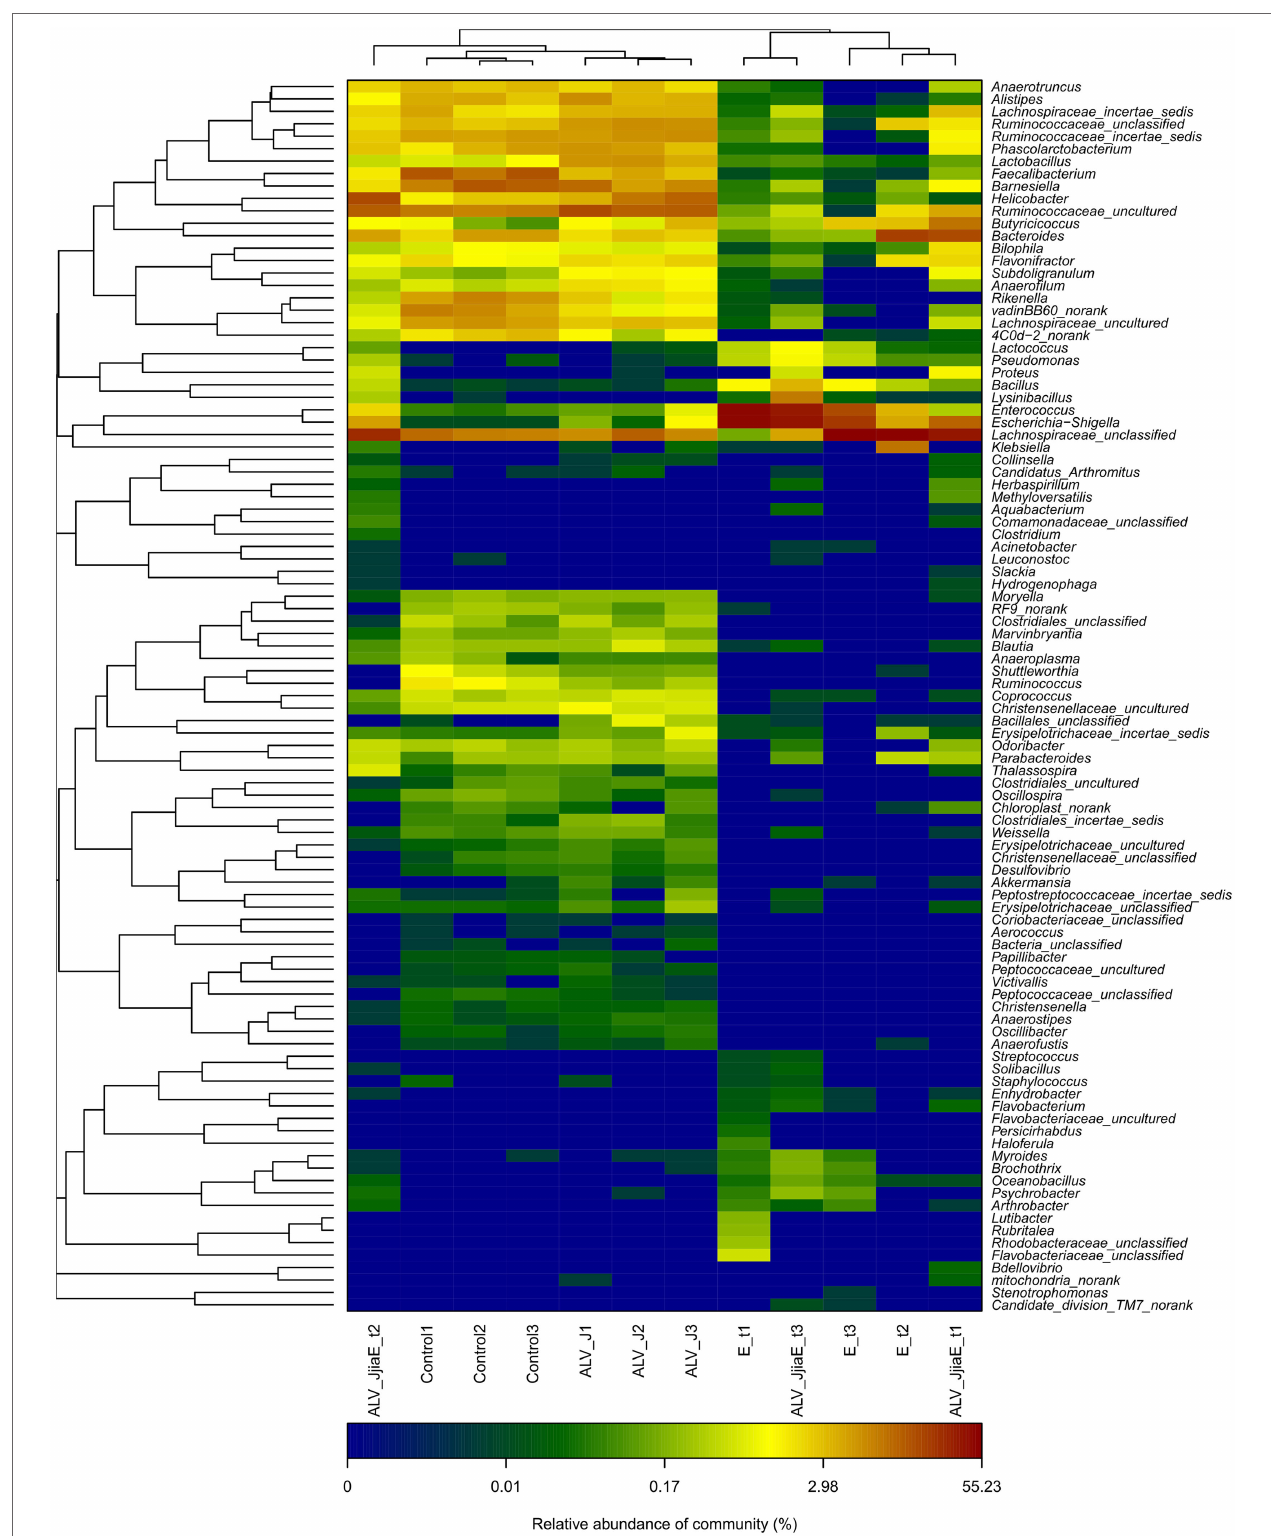
FigUre 4 | The heatmap of top 100 genera between different groups. Double hierarchical dendrogram shows the bacterial distribution. The heatmap plot depicts the relative percentage of each bacterial genus within each sample. The relative values for bacterial family are indicated by color intensity with the legend indicated under the